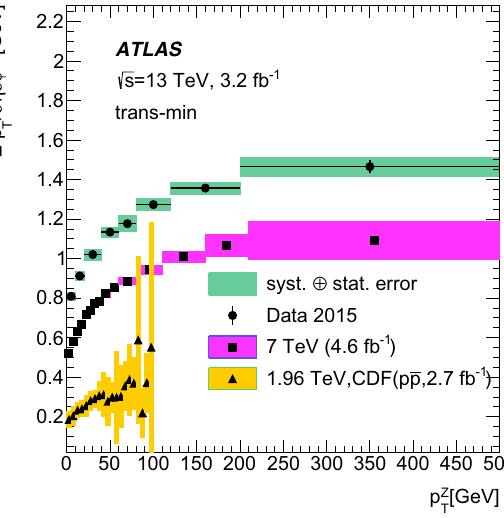
√ s = The error bars correspond to the full uncertainties of the corresponding measurement √ s =1.96 Tev [43].